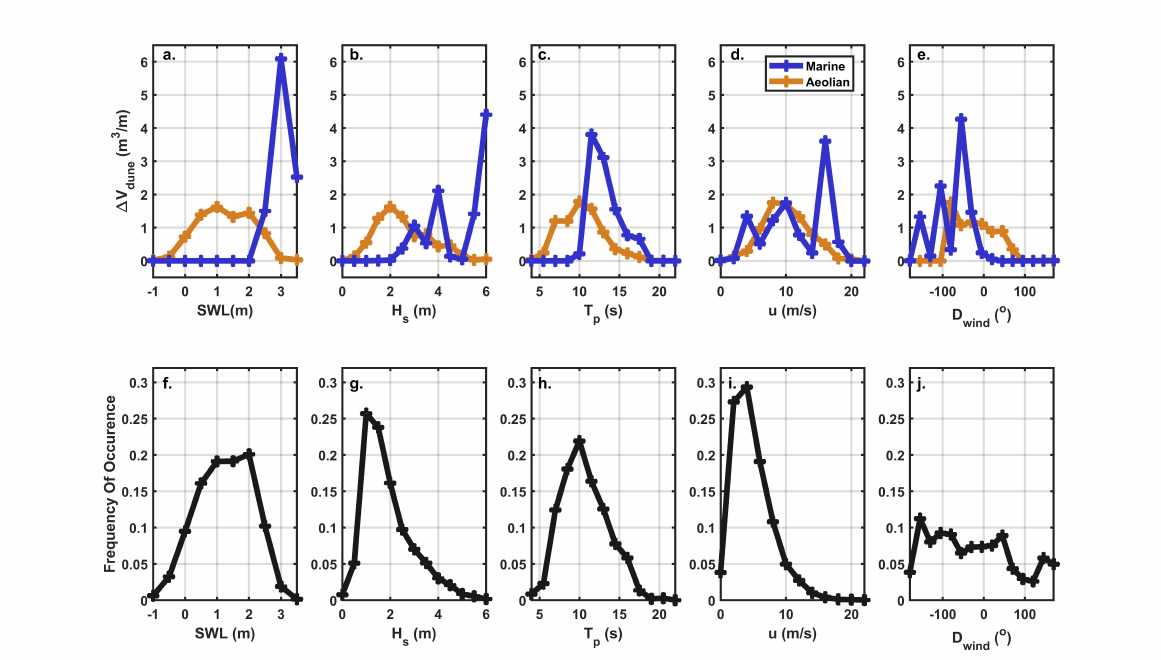
Figure 8. Marine (blue line) and aeolian (orange line) contributions to dune volume change binned based on ( a ) SWL, ( b ) H s , ( c ) T p , ( d ) u, and ( e ) D wind for the one-year calibrated Windsurf simulation. The frequency of occurrence of each ( f ) SWL, ( g ) H s , ( h ) T p , ( i ) u, and ( j ) D wind forcing condition are also shown for the one-year record for